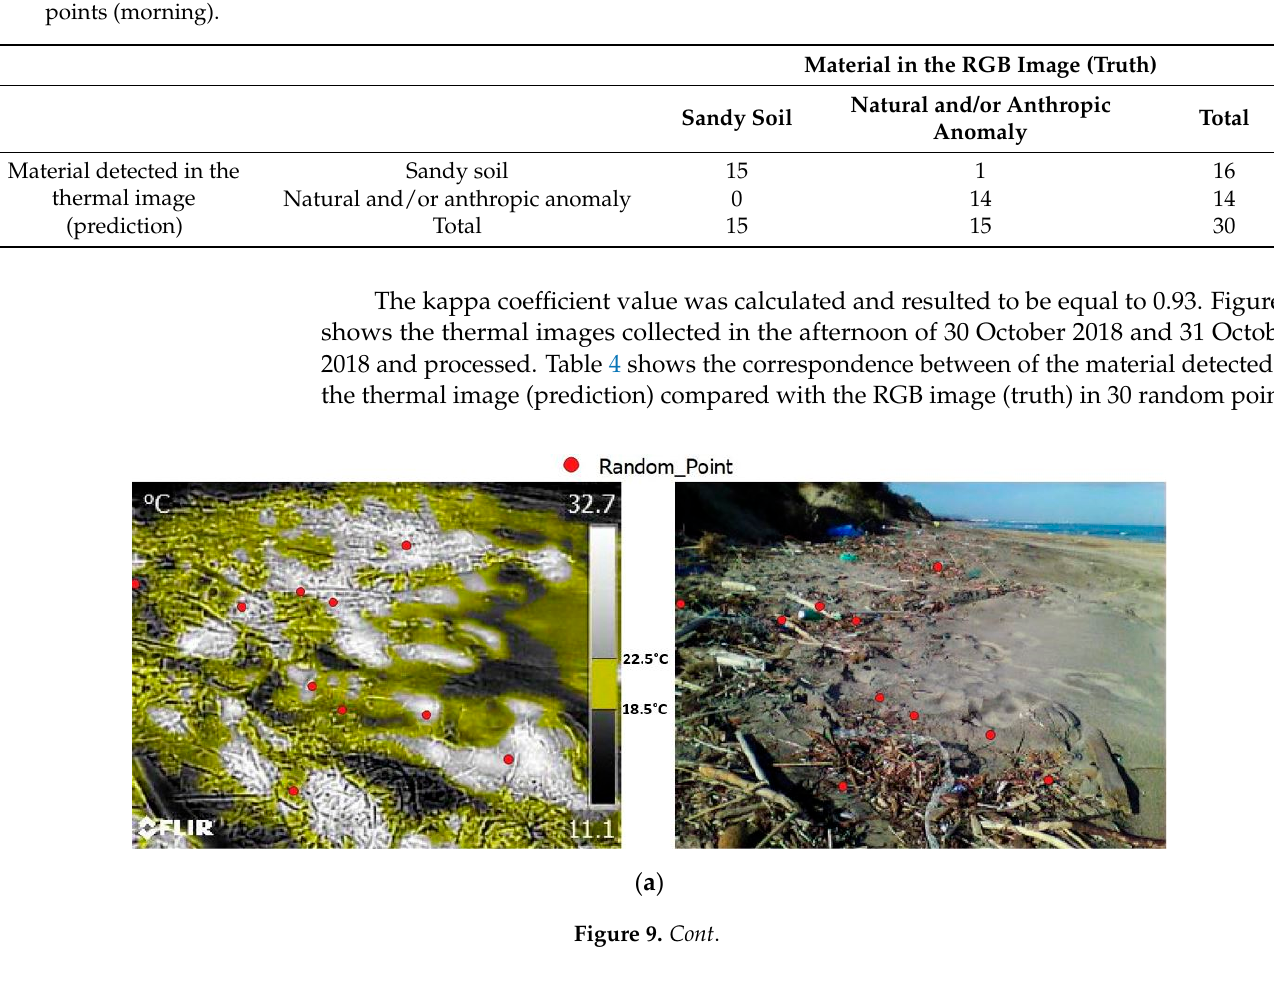
Figure 8. Morning acquisition: thermal image (on the left) and RGB image (on the right). Randomly selected points (in red). The yellow pixels in the thermal image indicate the sandy soil surface identified by the application of the empirical Equation (2). Plastic bottles can be seen in ( a ), rubber soles in ( b ), glass bottles and expanded polystyrene in ( c ). Table 3. Correspondence between the material detected in the thermal image and the RGB image in the selected points (morning). Material in the RGB Image (Truth)